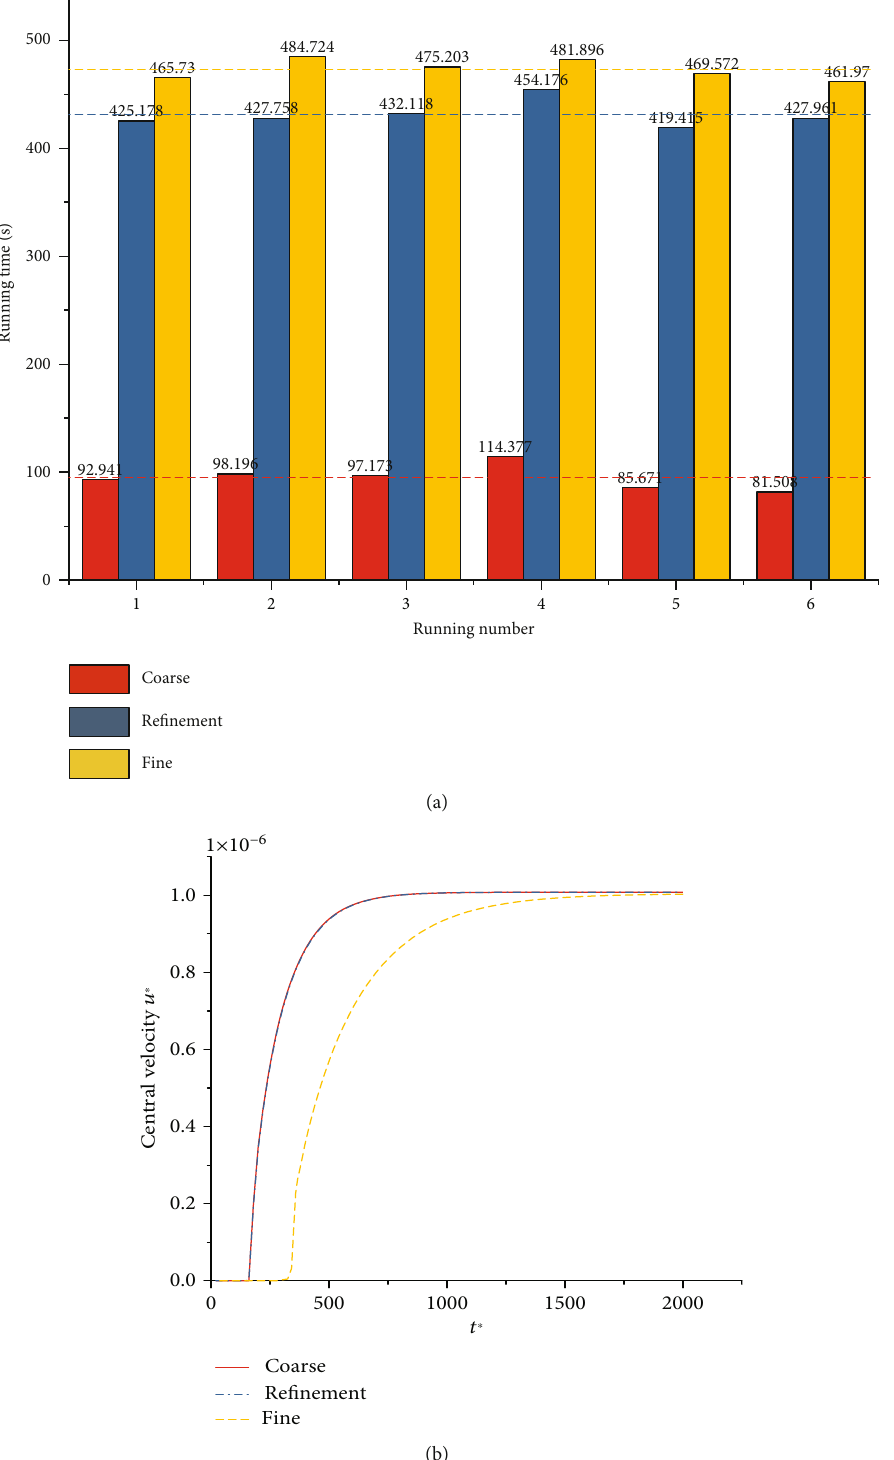
Figure 8: (a) Running time when t ∗ = 2000 . (b) The central velocity change with dimensionless time step in di ff erent grid